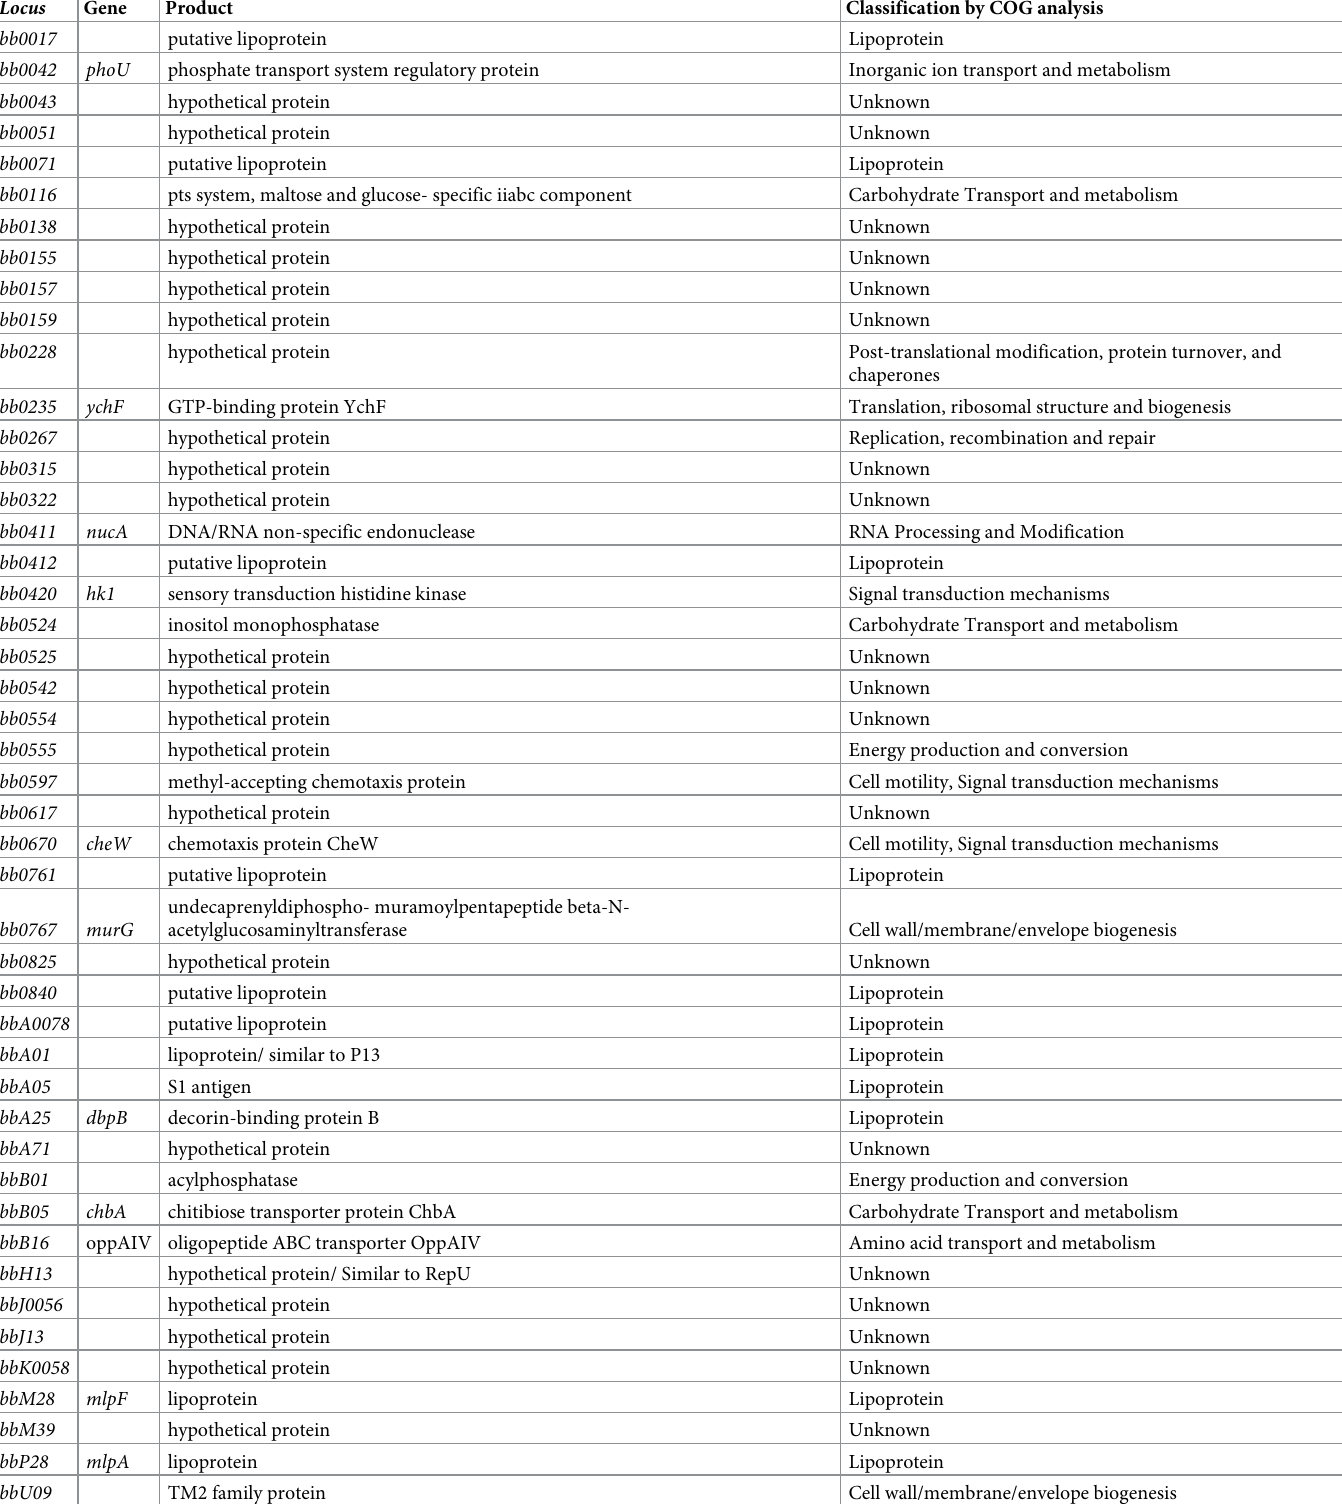
Table 2. List of Borrelia burgdorferi transposon mutants not recovered from larval ticks.